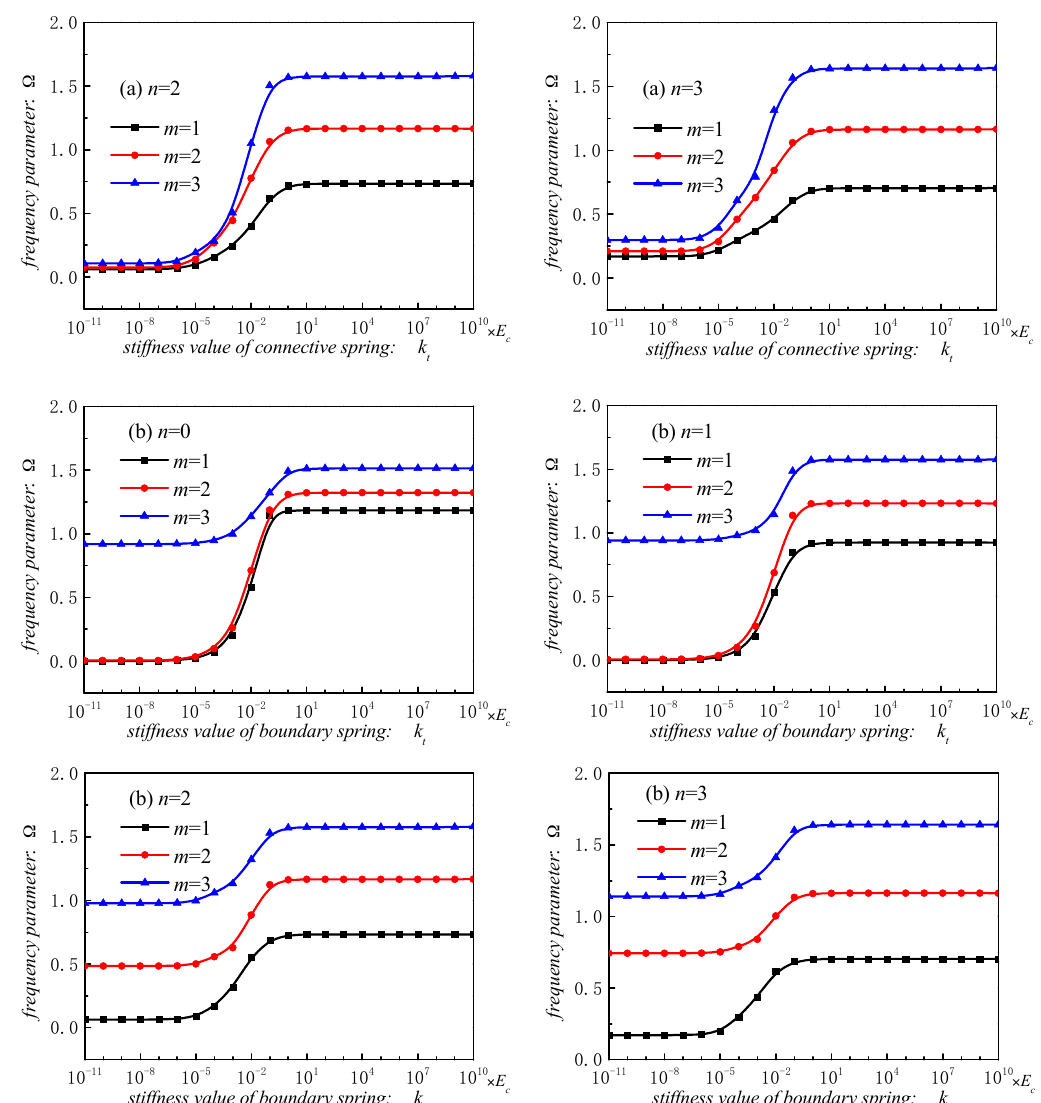
Figure 4. Frequency parameters Ω of stepped FG paraboloidal shell with various boundary parameters. Table 1. Spring stiffness values.